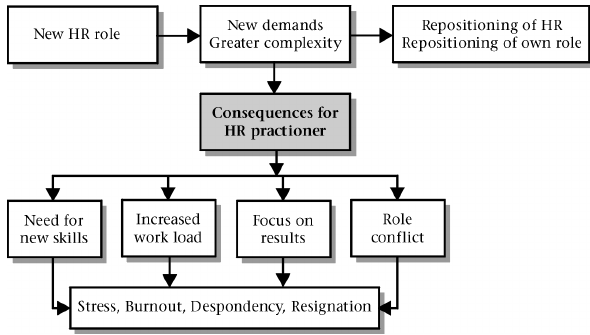
Figure 3: Effect of HR roles on